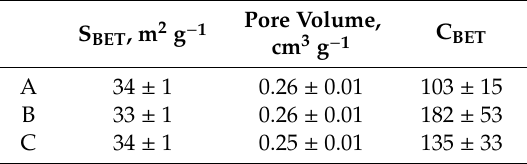
Table 1. Textural parameters of synthesized SCCs A–C.